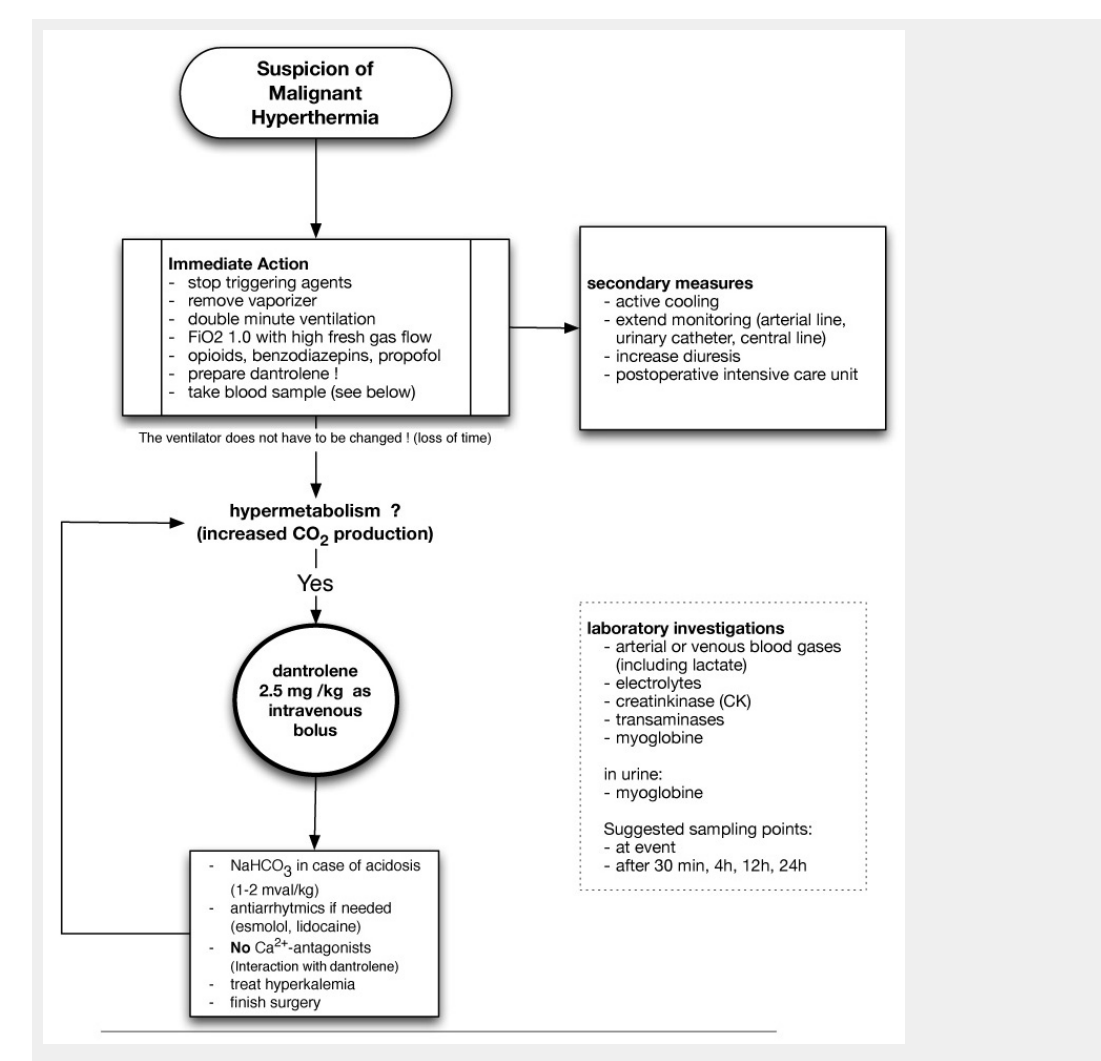
Figure 2 Treatment algorithm for malignant hyperthermia according to the Swiss MH investigation